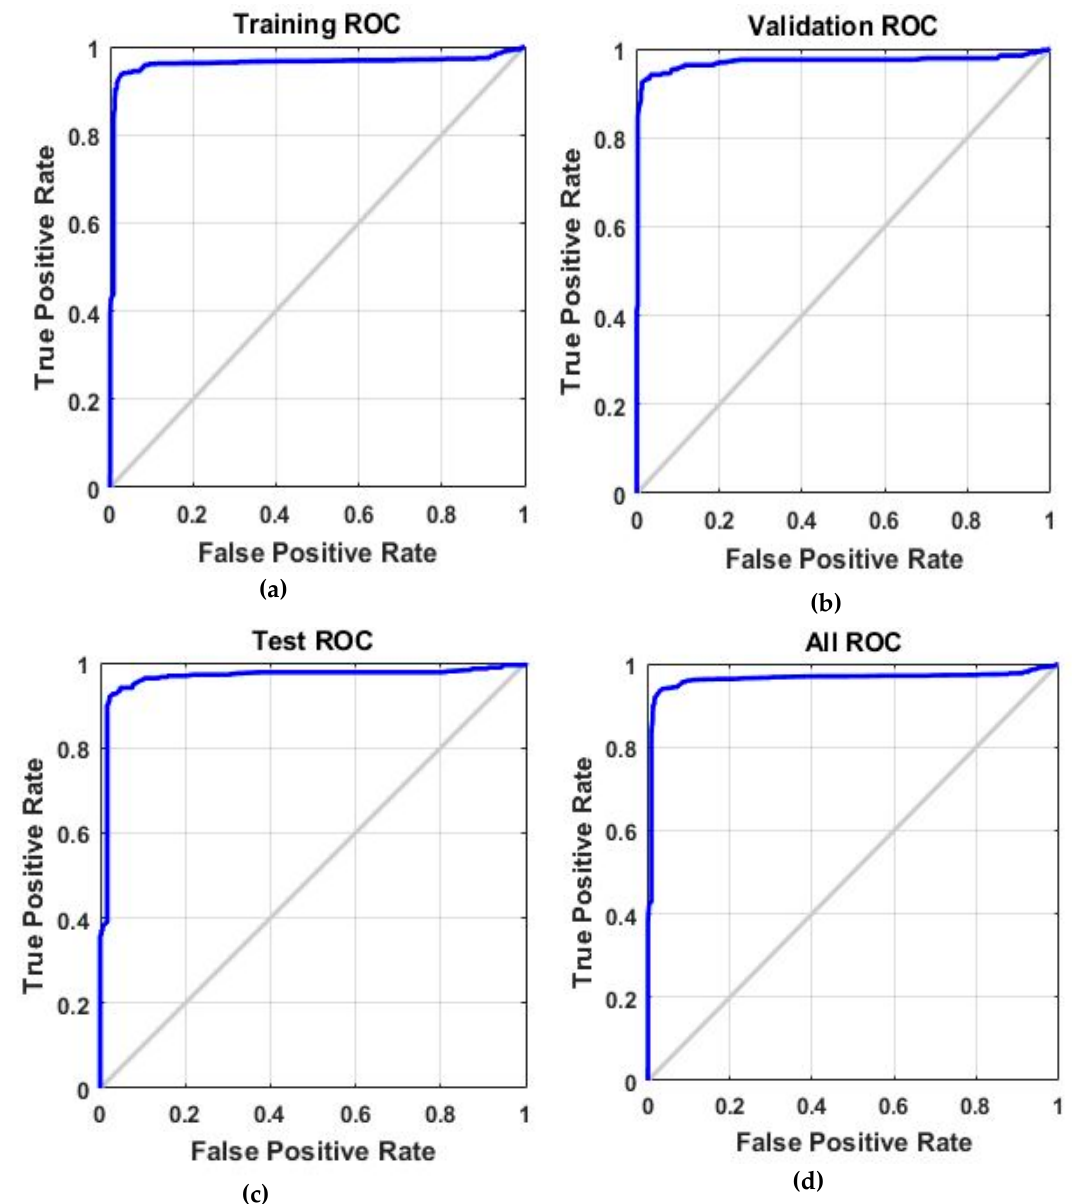
Figure 18. The best validation performance at epoch 23, validation error at the lowest point.